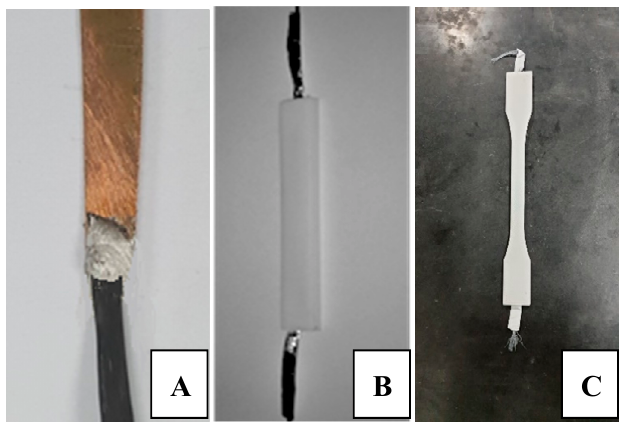
Figure 2. ( A ) Soldered port to copper, ( B ) ABS printed samples, and ( C ) printed to standard sample.